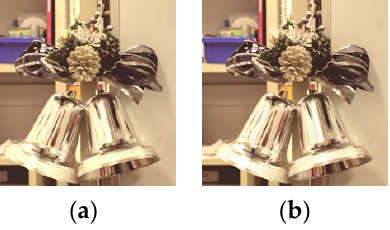
Figure 10. Images with logarithmic function applied (FireHD8). ( a ) threshold: 0.9 parameter: 1.5; ( b ) threshold: 0.9 parameter: 3.5.